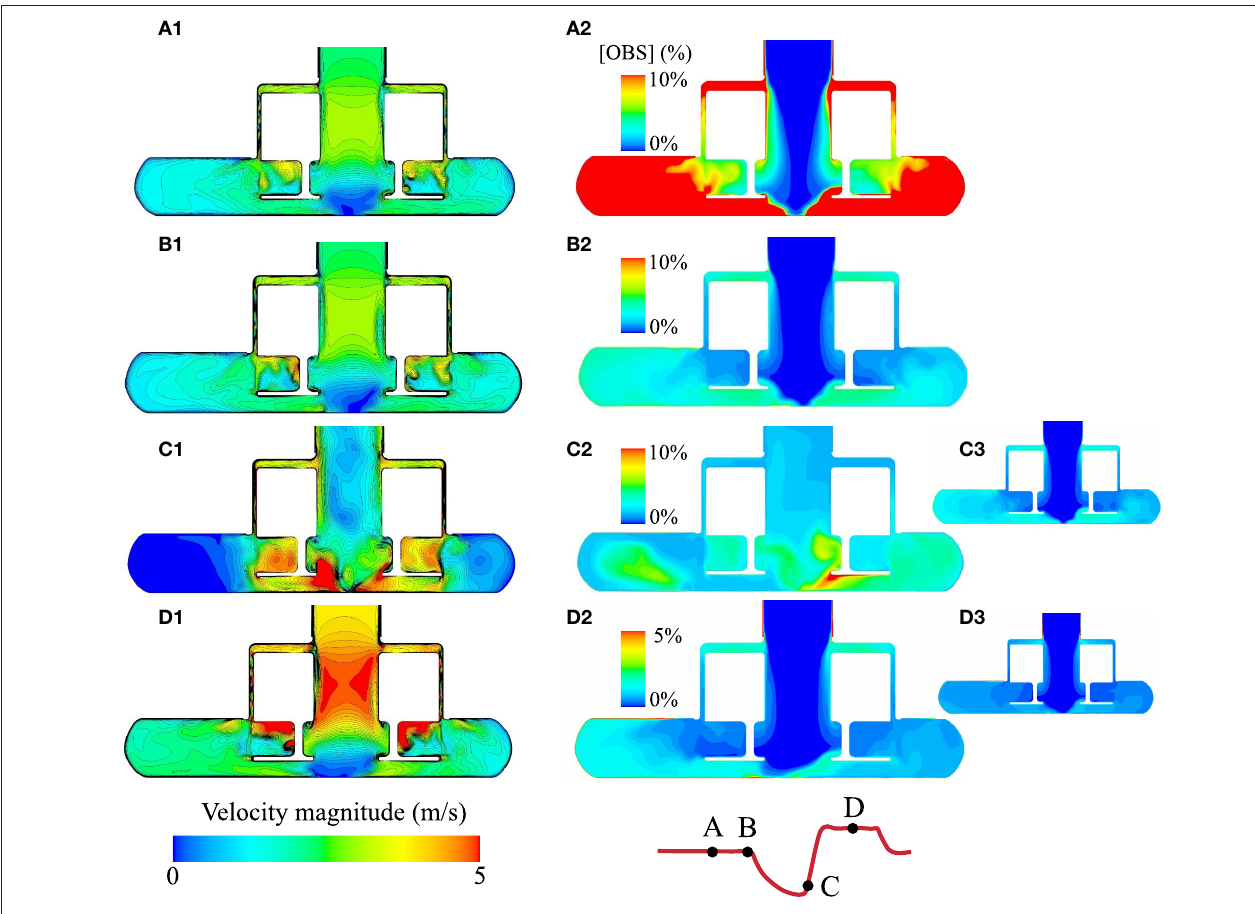
FIGURE 6 | Comparison of the instantaneous velocity fields and evolution of the OBS concentrations in the pump core during the AP1 scenario. (A1–D1) Instantaneous velocity fields in the HM3 pump core for the four instants illustrated on the flow curve with the pump operating at baseline speed (5,650 rpm, instants A and B), low speed (3,650 rpm, instant C), and high speed (7,650 rpm, instant D). For AP1, the time points A, B, C, and D correspond to V f = 0.9, 1.4, 1.5, and 2.0, respectively. (A2–D2) OBS concentrations at instants A, B, C, and D for the AP1 scenario. OBS concentrations are expressed as a percentage of the initial concentration [OBS] 0 . rOBS over the core pump for the AP1 scenario is 14.0, 2.6, 4.0, and 0.9% at the instants A, B, C, and D, respectively. (C3,D3) OBS concentrations in the pump core for V f = 1.5 and 2.0 under baseline conditions, corresponding to the same flush volumes as instants C and D for AP1. Note that instants A and B apply to the baseline scenario as well, as the pump is operating under the set baseline speed at those time